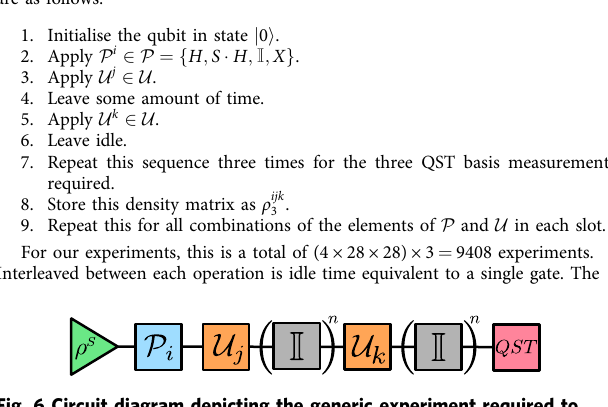
Fig. 6 Circuit diagram depicting the generic experiment required to construct the two-step process tensor. Each gate represents an element from either the preparation set P or the more general unitary basis set U . The identity gates represent idle time which we allow to vary. Finally, measurements in three bases are made for